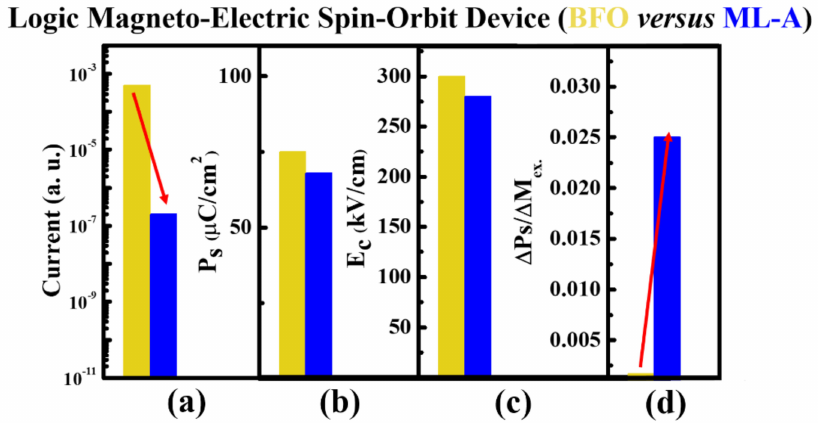
Figure 7. The comparisons of the ( a ) leakage current (J g ), ( b ) P s , ( c ) E c , and ( d ) ∆ P s / ∆ M ex. for the pure 100 nm BiFeO 3 (BFO) thin film and our designed multi-layer (ML) BaTiO 3 (BTO)/BiFeO 3 (BFO) structures for Condition A (ML-A) for the investigation of the magneto-electric effect. It shows that our proposed multi-layer BFO/BTO structures can have both a lower leakage current and a superior characteristics of ∆ P s / ∆ M ex. at the same